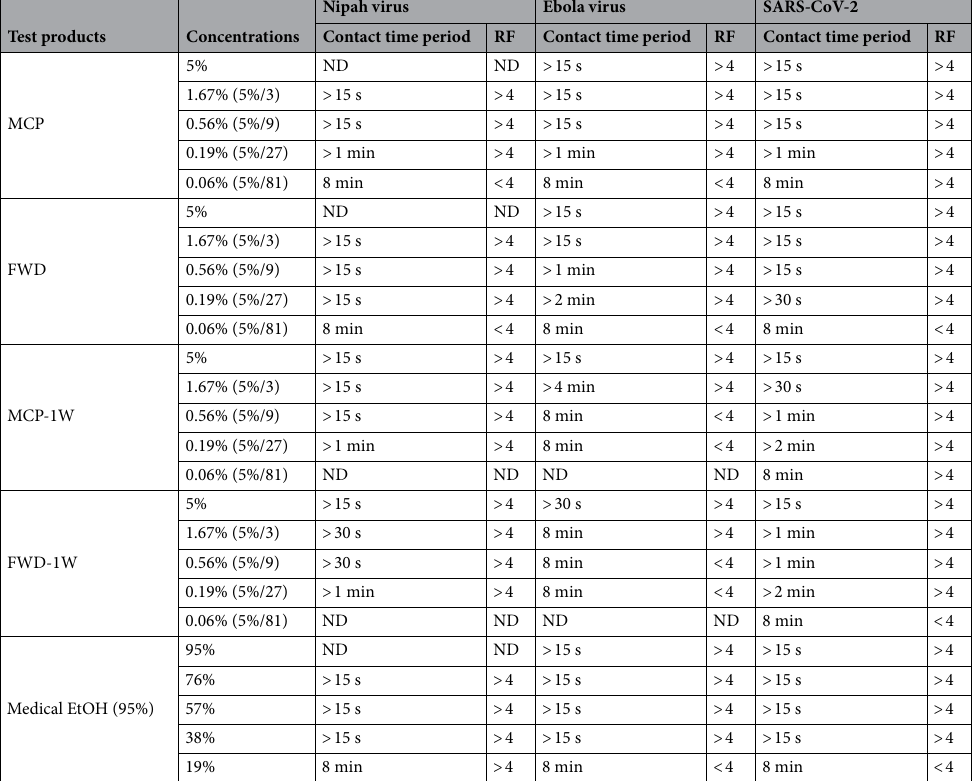
Table 4. Summary of reduction factors of three disinfectants against Nipah virus, Ebola virus and SARS- CoV-2. ND: not